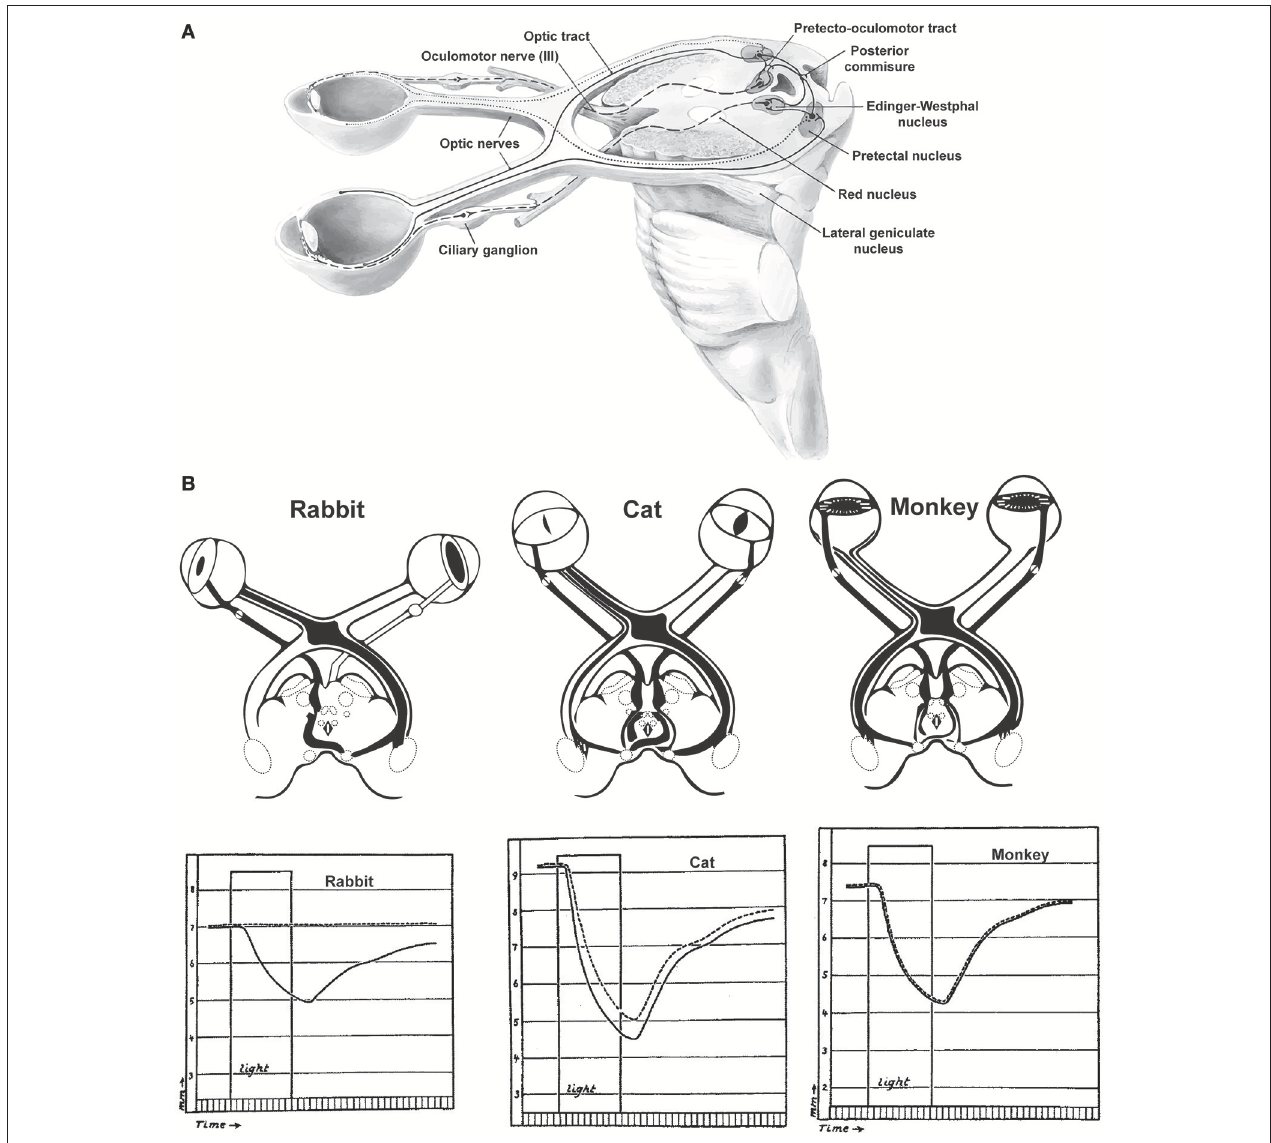
FIGURE 1 | The pupillary light reflex. (A) Neural circuits involved in the pupillary light reflex. (B) Responses of various species to light stimulation of the left eye. In rabbits, which lack many decussating optic axonal fibers, unilateral light stimulation produces no consensual light reflex in the contralateral eye (dashed lines). In contrast, species which have more decussating than non-decussating fibers have either imperfect consensual reactions to unilateral light stimulation (cats) or symmetric direct consensual reactions (monkeys). Duration of the light stimulation is indicated by the rectangular “light” period in each plot. Reprinted with permission from Kardon